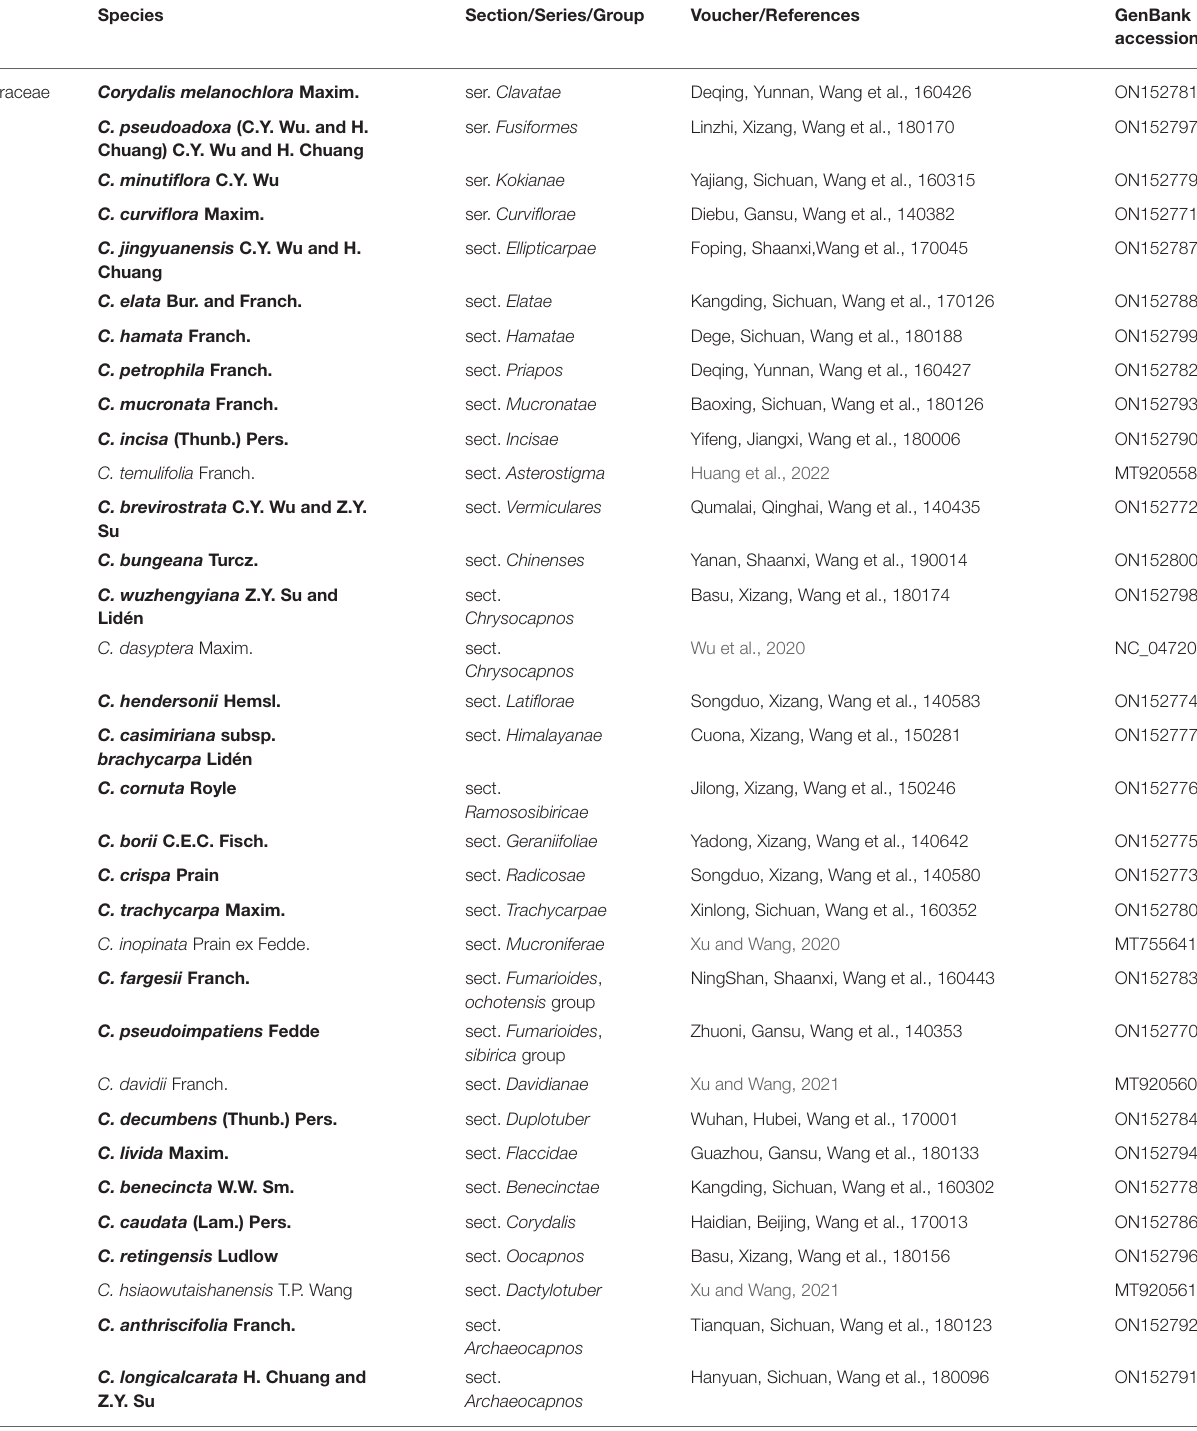
TABLE 1 | Taxa, vouchers/references, and GenBank accession numbers used in phylogenetic analyses.